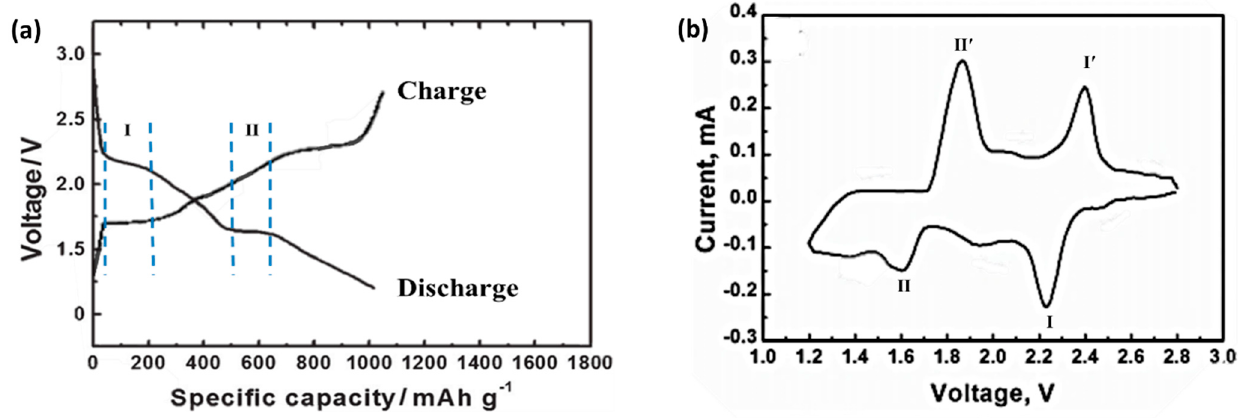
Figure 1. ( a ) Charge-discharge and ( b ) cyclic voltammetry (CV) curves of typical room temperature sodium sulfur batteries.